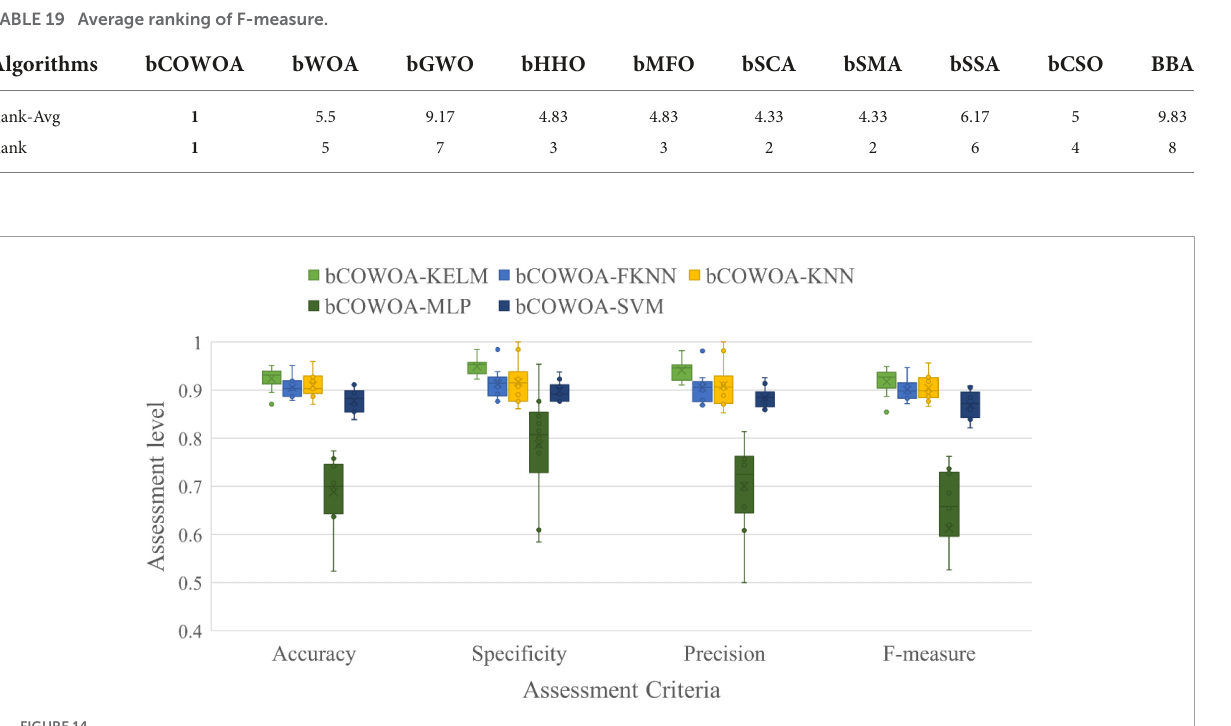
FIGURE14 Comparison results of the five bonding